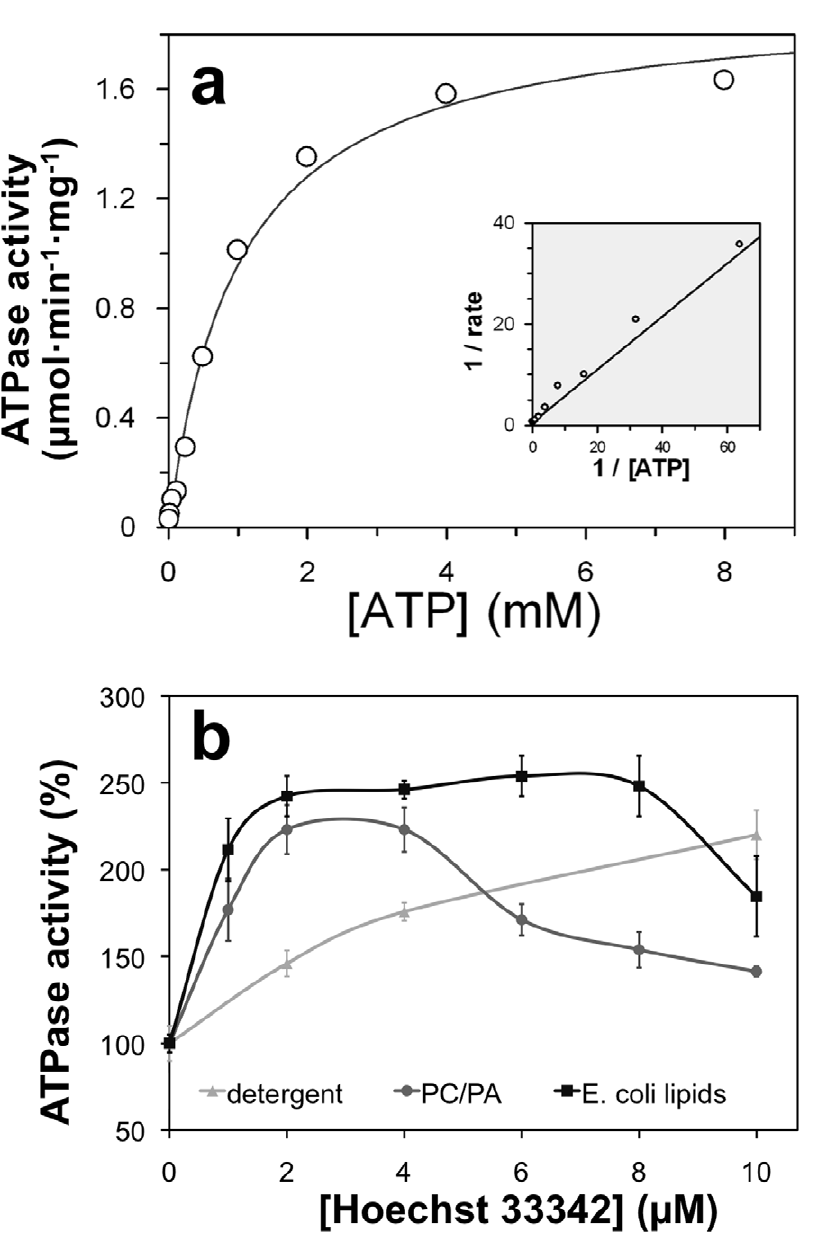
Figure 4. Reconstitution of BmrC/BmrD into proteoliposomes. BmrC/BmrD were reconstituted at lipid to protein ratio of 40 (w/w) by detergent removal from different solubilized mixtures of DDM/lipid/protein. ( a ) ATPase activity of proteoliposomes was assessed at 4 mM ATP. E. coli : total extract of E. coli phospholipids; PC: egg-phosphatidylcholine; PA: egg-phosphatidic acid; chol: cholesterol; DOPC: dioleoylphosphatidylcholine; DOPG: dioleoylphosphatidylglycerol; CL: cardiolipin. Lipid composition was as follows (w/w): PC/PA 9:1; PC/PA/chol 7:1:2; DOPC/DOPG 9:1; PC/CL 8:2. ( b ) Cryo-electron microscopy of reconstituted proteoliposomes with EPC/EPA. All proteoliposomes were unilamellar and showed a continuous lipid bilayer. Scale bar: 50 nm. ( c ) ATPase activity measured after reconstitution of BmrC/BmrD with EPC/EPA or E. coli lipids at lipid to protein ratio of 40 (w/w) and 100 (w/w). ( d ) Protein incorporation in proteoliposomes after fractionation in a sucrose gradient. The amount of BmrC/BmrD in every fraction was measured by quantitation of the protein bands revealed by immunoblot (the intensity of both bands were added) and normalization to the total amount of BmrC/BmrD loaded onto the sucrose gradient (cf. Materials and Methods). Most proteins were reconstituted in proteoliposomes running at 2.5%–5% sucrose without significant aggregates at 30%